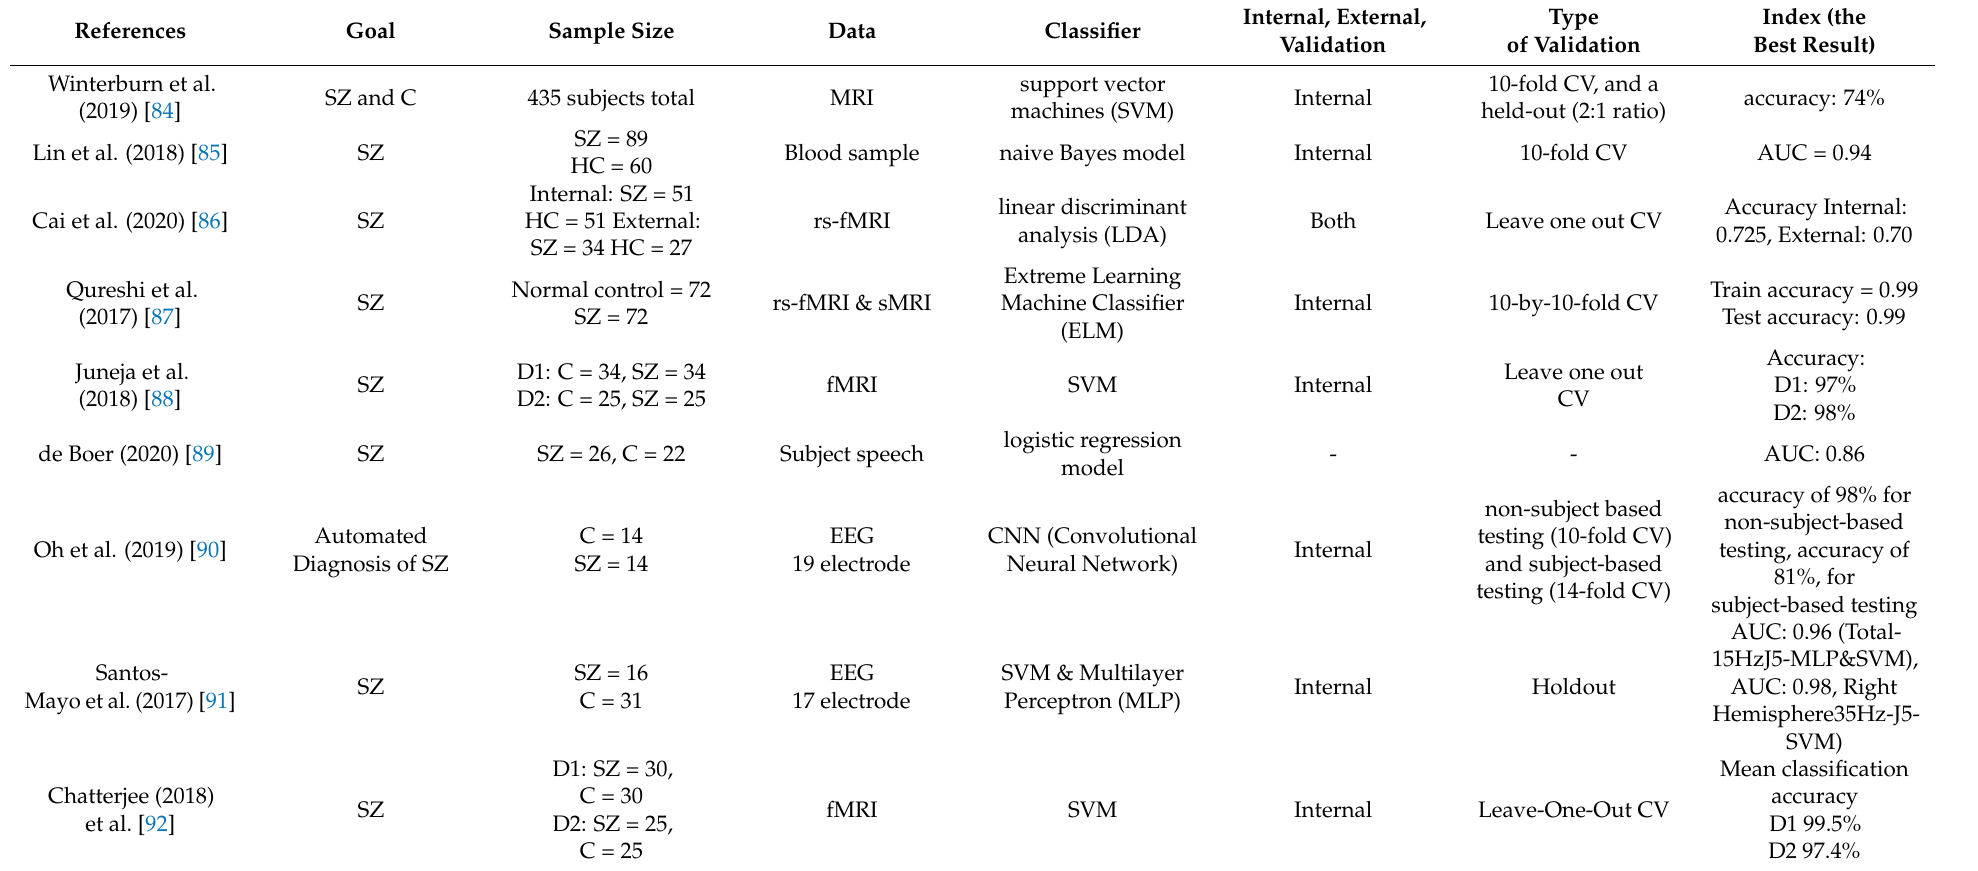
Table 4. CAD methods for mental and neurological disorders